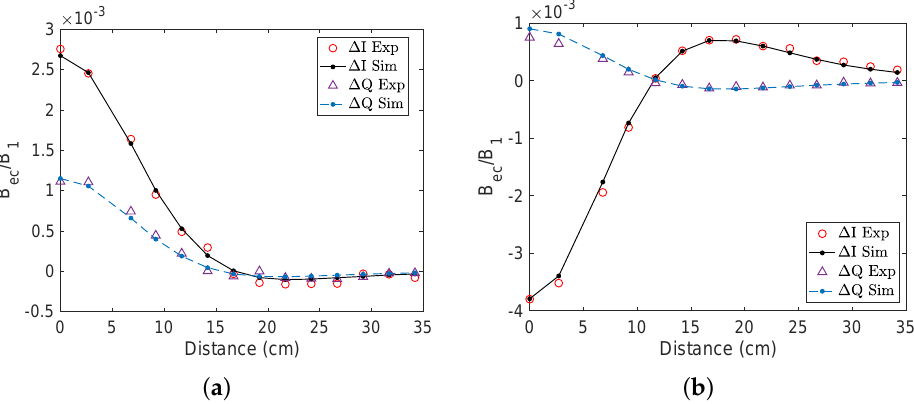
Figure 9. In-phase and out-of-phase components of the signal detected as the conductive objects were varied off-axis at 500 Hz for ( a ) the solid aluminium cylinder and ( b ) the solid steel